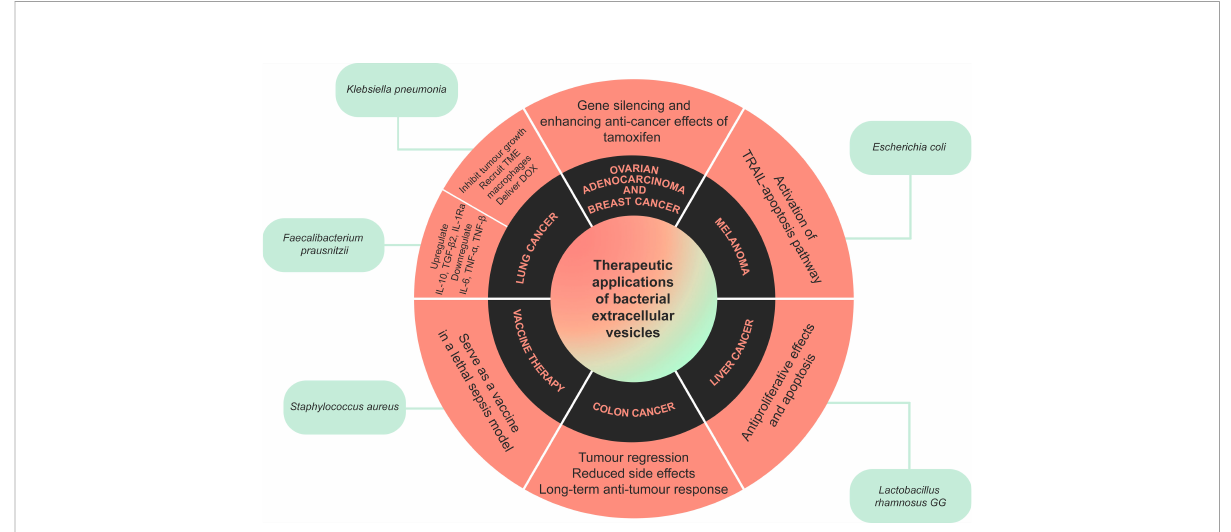
FIGURE 2 A summary of the therapeutic applications of bacterial extracellular vesicles (BEV). BEV released by certain bacteria have been shown to have bene fi cial anti-cancer and anti-in fl ammatory effects in cancers such as colon, breast, lung, and liver cancer, melanoma and ovarian adenocarcinoma. Extracellular vesicles released by Staphylococcus aureus can also trigger the immune system, serving as a vaccine in a model of lethal